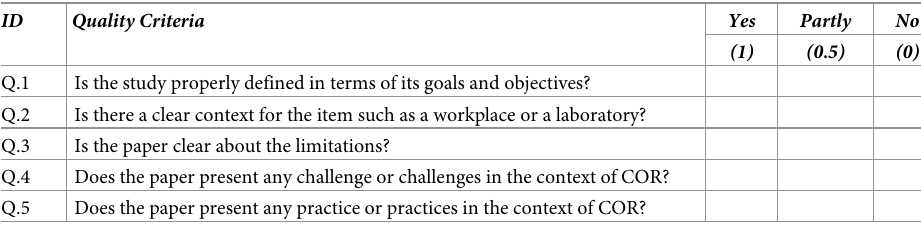
Table 2. Quality based assessment